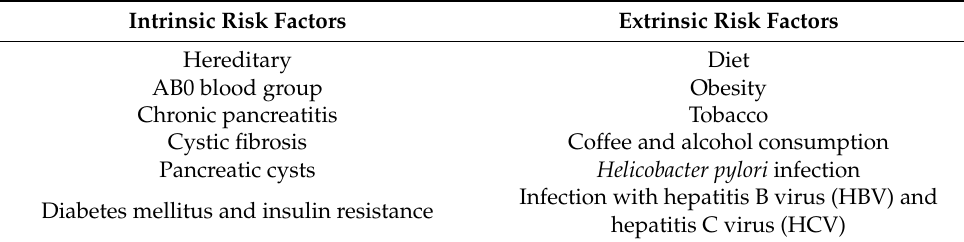
Table 1. Risk factors for pancreatic cancer